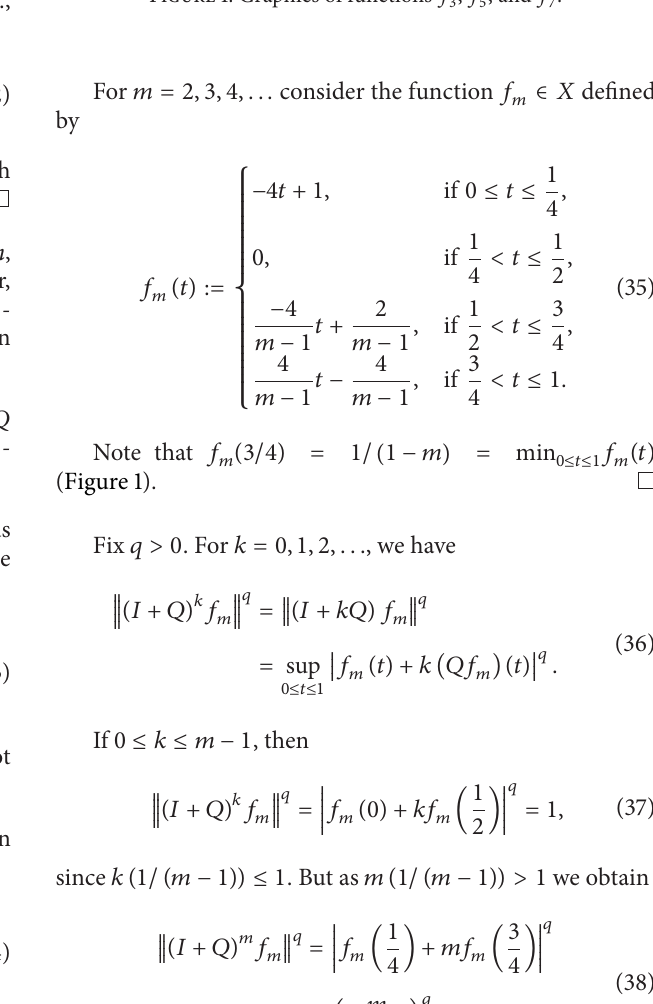
Figure 1: Graphics of functions 𝑓 3 , 𝑓 5 , and 𝑓 7